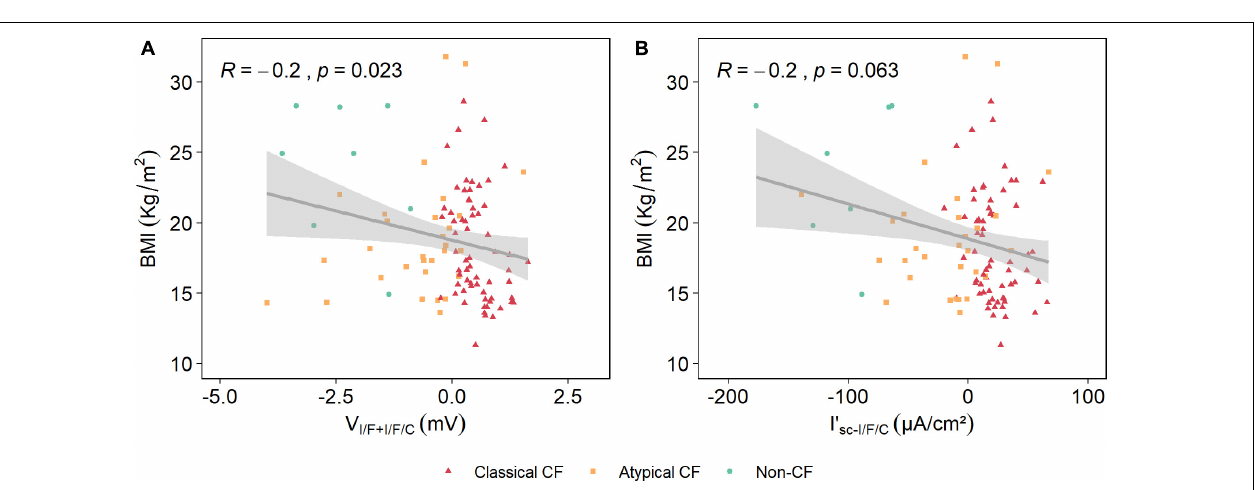
FIGURE 6 | Correlation of body mass index (BMI) with V I / F + I / F / C and I’ sc − I / F / C . A Spearman correlation analysis showed that the correlation between BMI and V I / F + I / F / C is 24% (A) , and that for I’ sc − I / F / C is 20% (B)